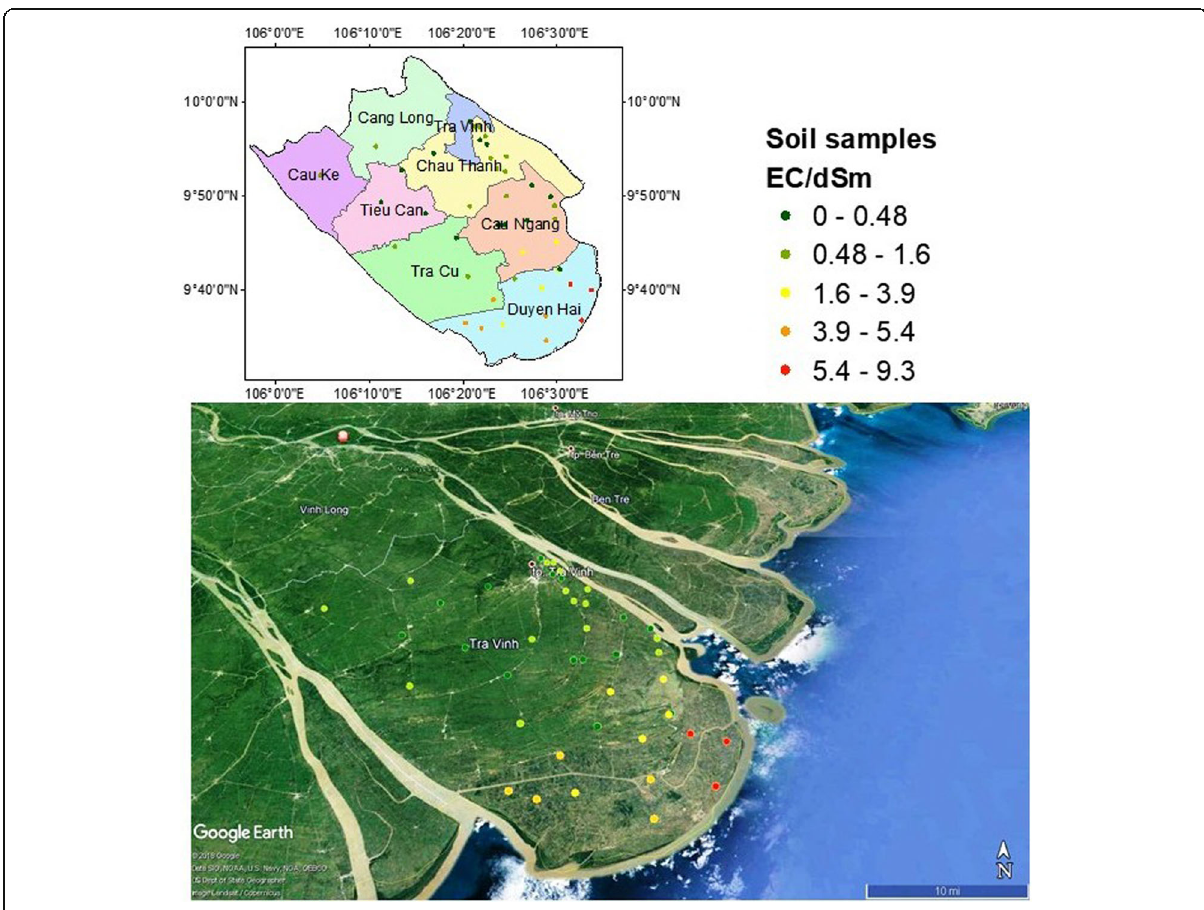
Fig. 3 Spatial distribution of soil samples and their measured EC 1:5 over Tra Vinh Province overlaid on Google Earth